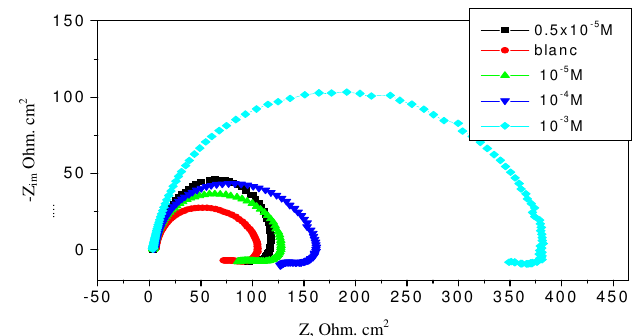
Figure 2. Nyquist diagram of C-steel in medium 0.5 M HCl at various concentrations of